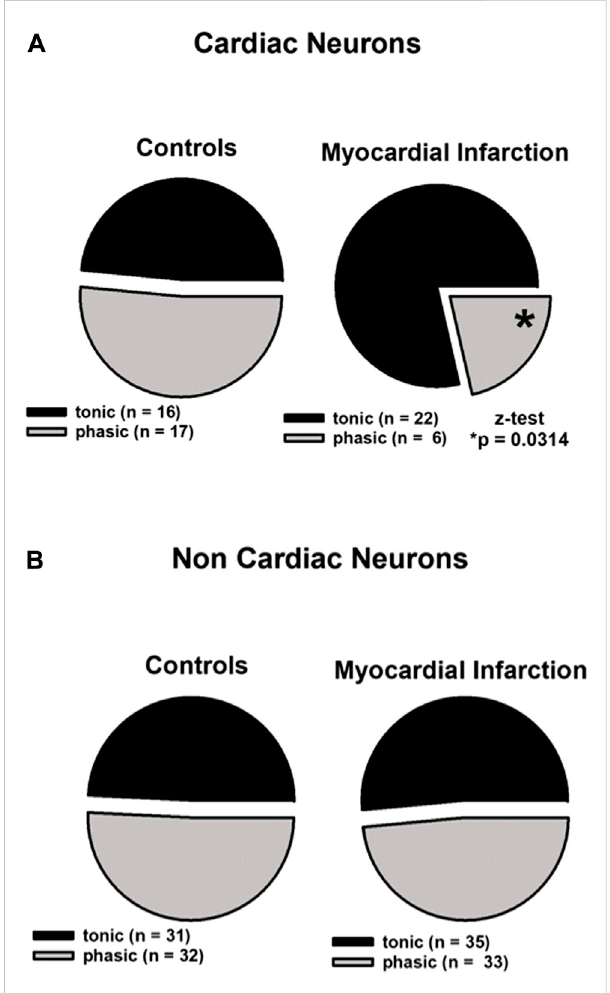
FIGURE 2 Myocardial infarction altered the fi ring pattern of cardiac afferent neurons. Inthecardiac andnon-cardiac samples, thetonic andphasic fractions did not differ in size regarding controls. Upper panels (A) : in cardiac neurons ( n = 61), a signi fi cant increase of the tonic fraction was observed in animals after myocardial infarction 78.6% [*(22 out of 28; myocardial infarction)vs. 48.5% (16 out of 33; control), p < 0.05]. Lower panels (B) : in non-cardiac neurons ( n = 131), myocardial infarction did not lead to signi fi cant changes of the tonic fraction [(35 out of 68; myocardial infarction) vs. (31 out of 63; control)]. Statistical analyses were performed using the z-test. Neurons were investigated in the current clamp mode of patch clamp